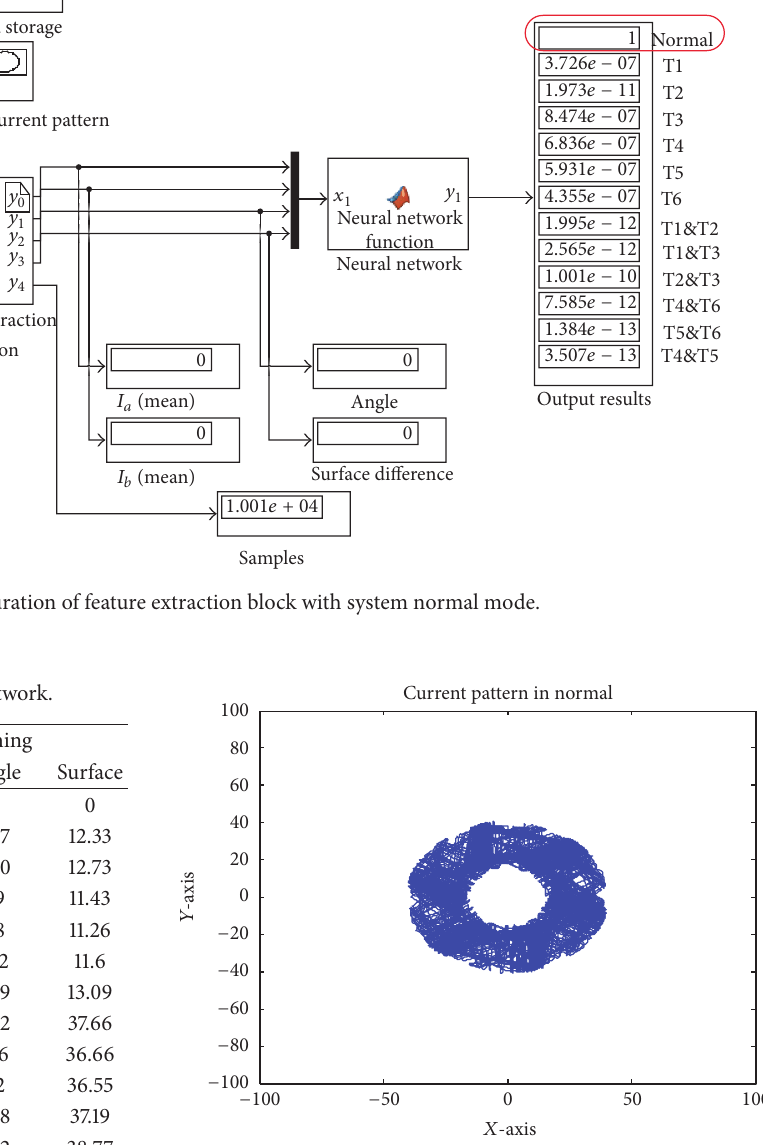
Figure 8: 𝛼 - 𝛽 transformed current pattern graph for system in normal